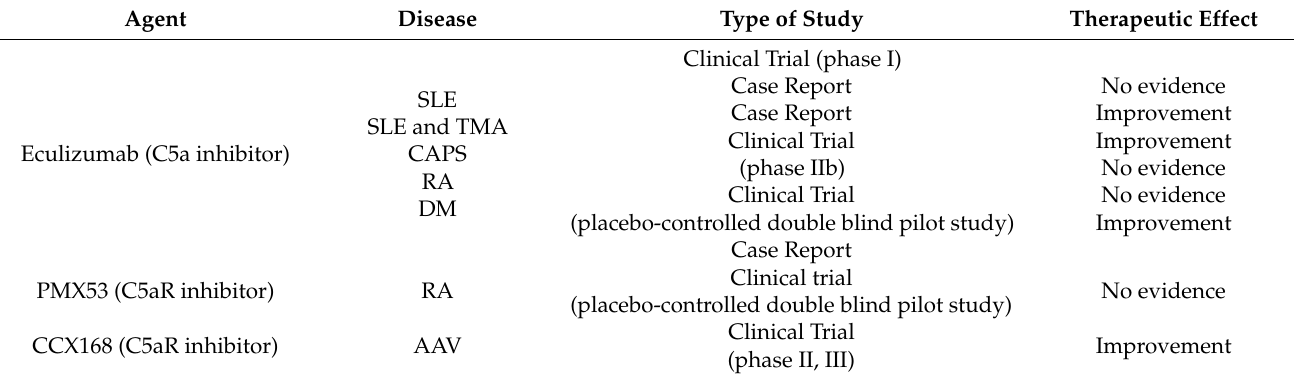
Table 2. Clinical studies of drugs targeting complement pathways in rheumatic autoimmune diseases. Agent Disease Type of Study Therapeutic Effect